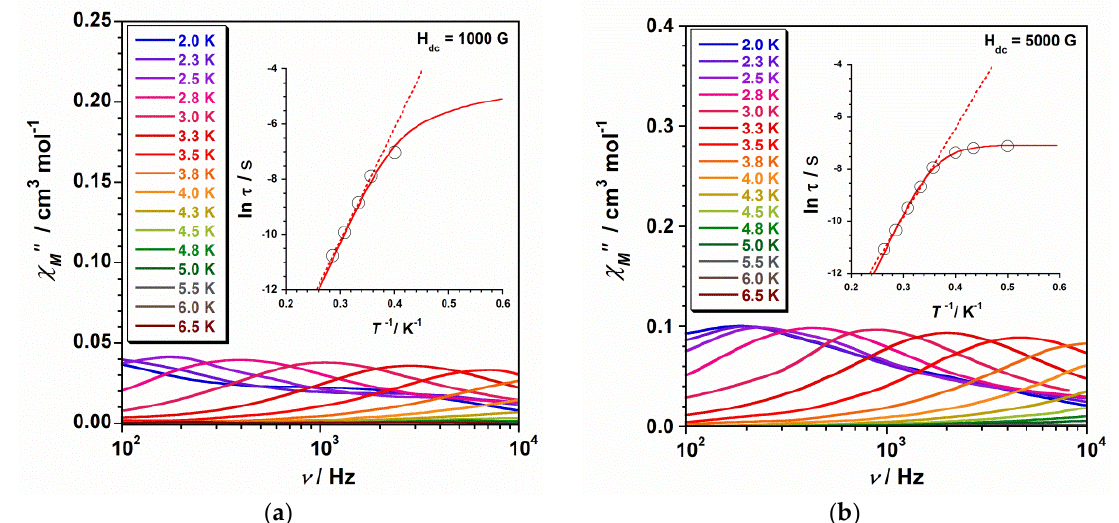
Figure 4. Frequency dependence of the out-of-phase ac susceptibility signals under dc fields of 1000 ( a ) and 5000 G ( b ) for compound 1 . The respective inset shows the ln(τ) versus 1/T plot for 1 with the fit to the Arrhenius law (dashed line) and the fit considering several mechanisms (solid line).